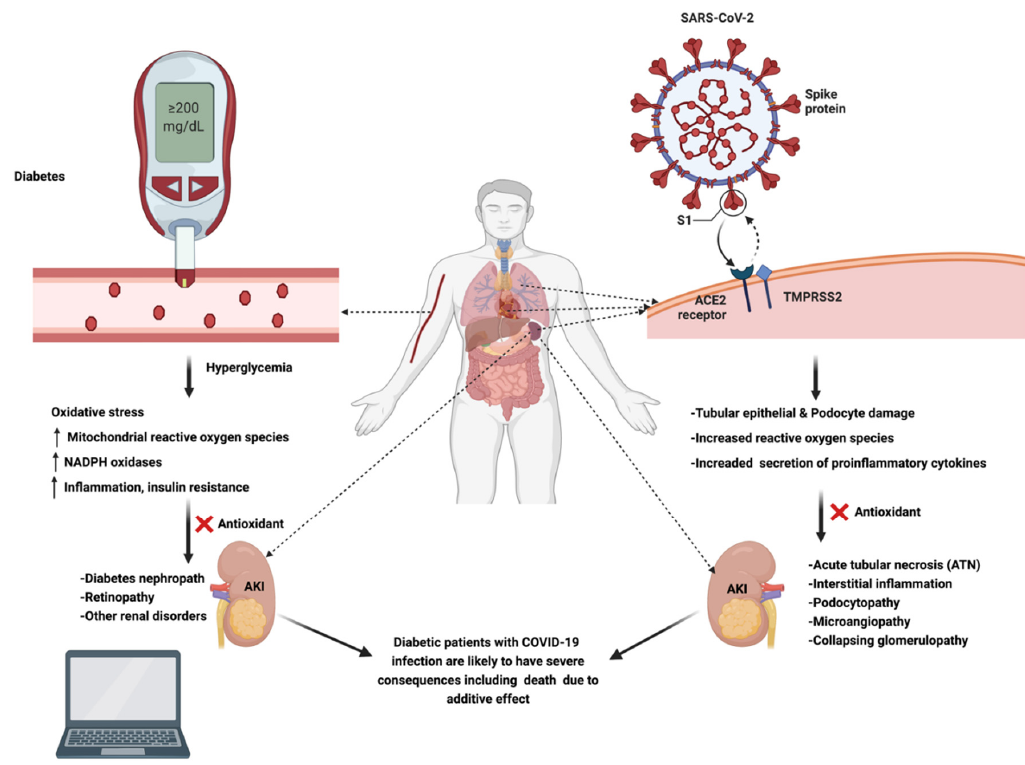
Figure 2. SARS-CoV-2 and diabetes induce kidney damage via oxidative stress: the role of antioxidants. Abbreviations: CKD, chronic kidney disease AKI, acute kidney injury; SARS-CoV-2, severe acute respiratory syndrome coronavirus-2; COVID-19, coronavirus disease 2019; TMPRSS2, Transmembrane protease serine 2. (The figure was made with www.biorender.com, accessed on 13 December 2021). ↑ : increase.